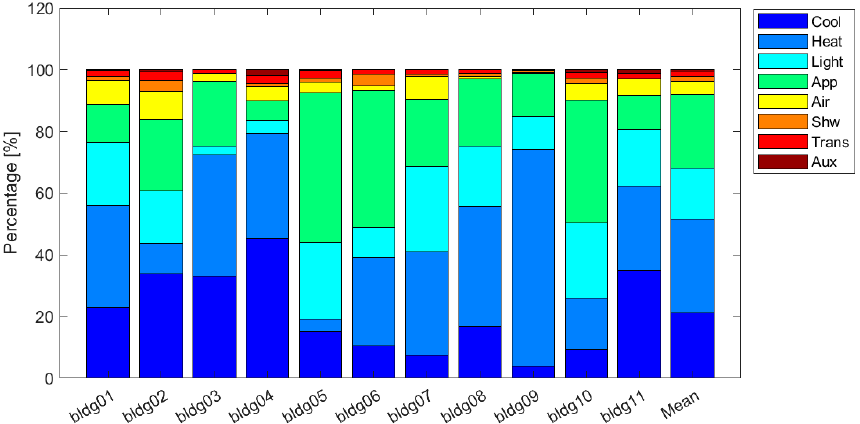
Figure 3. Ratio of the end-use consumption. Cool : space cooling, Heat : space heating, Light :